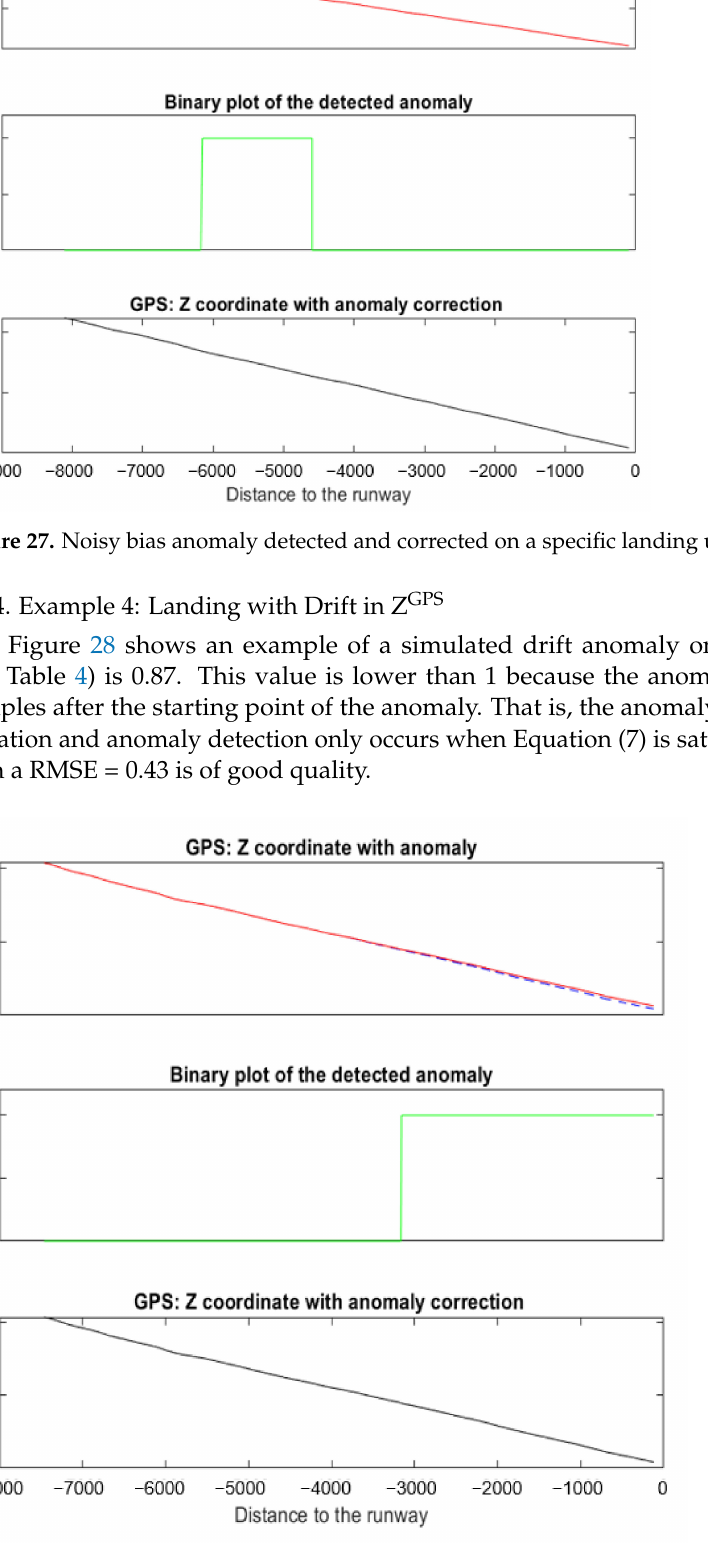
Figure 28. Drift anomaly detected and corrected on a specific landing using